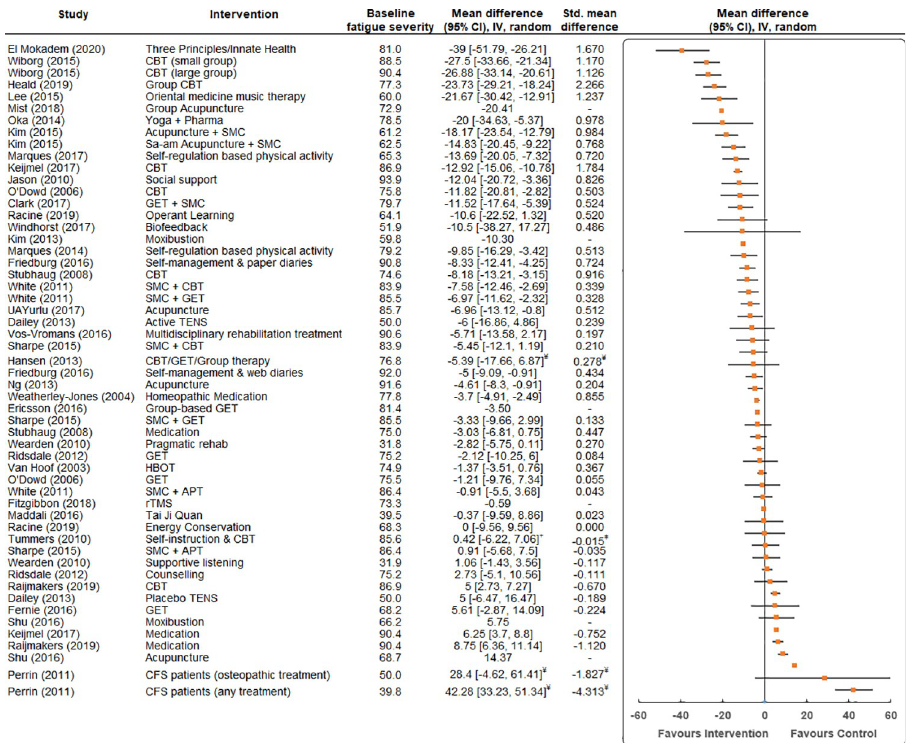
Fig 2. Mean differences (95% Confidence Intervals (CI), Inverse Variance (IV)) for fatigue in studies assessing the effectiveness of interventions for reducing fatigue severity. Fatigue is expressed on a 0–100 scale. Studies are ordered by the mean difference between the average score of participants in the intervention group and participants in the control group. The baseline fatigue severity of each group and the effect size (standardised mean difference (SMD, Cohen’s d and Hedges’ g)) of each intervention is also listed. ǂ = non-inferiority trial to see if one treatment is no less effective than the other, ¥ = fatigued individuals vs healthy